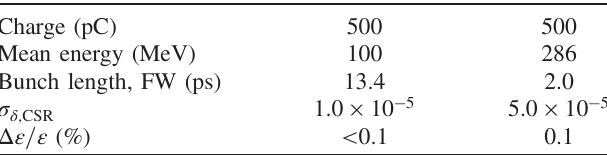
TABLE II. Beam parameters and CSR effect across